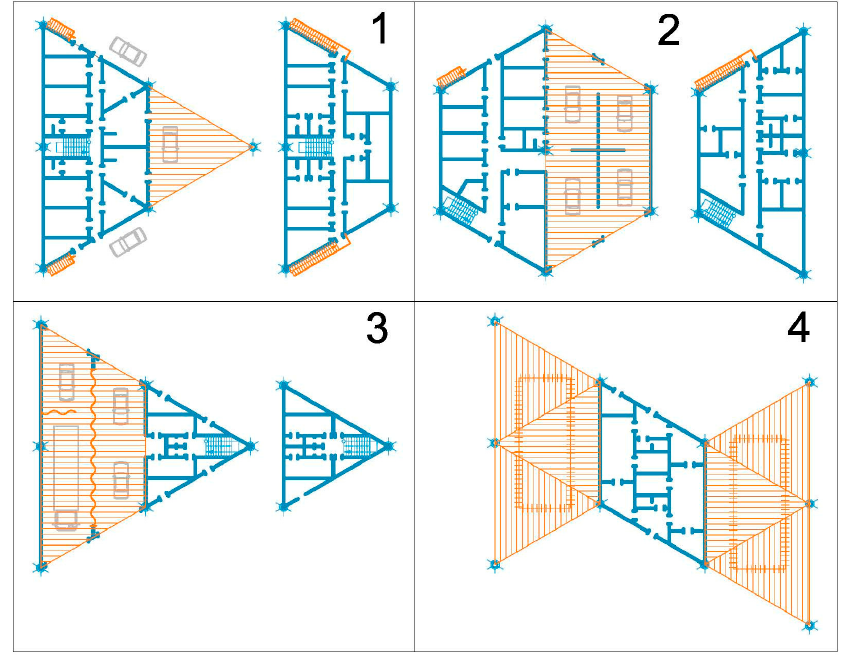
Figure 5. Planning solutions: 1—the Point of medical and rescue service—1st, 2nd floors; 2—the Car Service station—1st, 2nd floors; 3—the Car wash (4 posts)—1st, 2nd floors; 4—the Point of weight